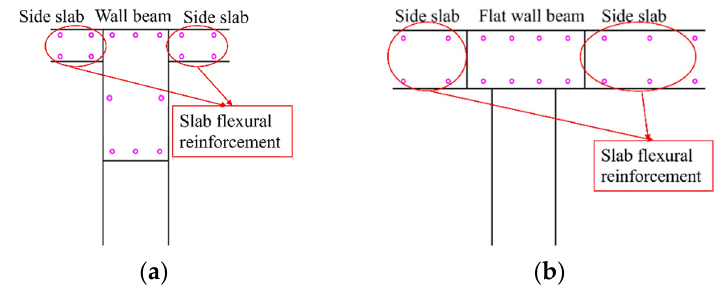
Figure 5. Bending moment transferring around walls: ( a ) in WRC case, ( b ) in TWTS case.